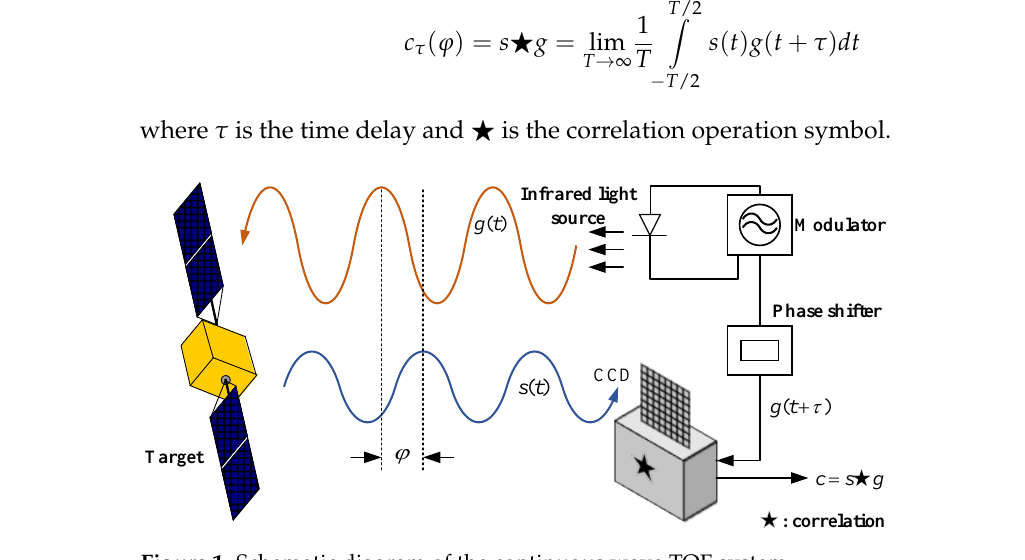
Figure 1. Schematic diagram of the continuous wave TOF system.